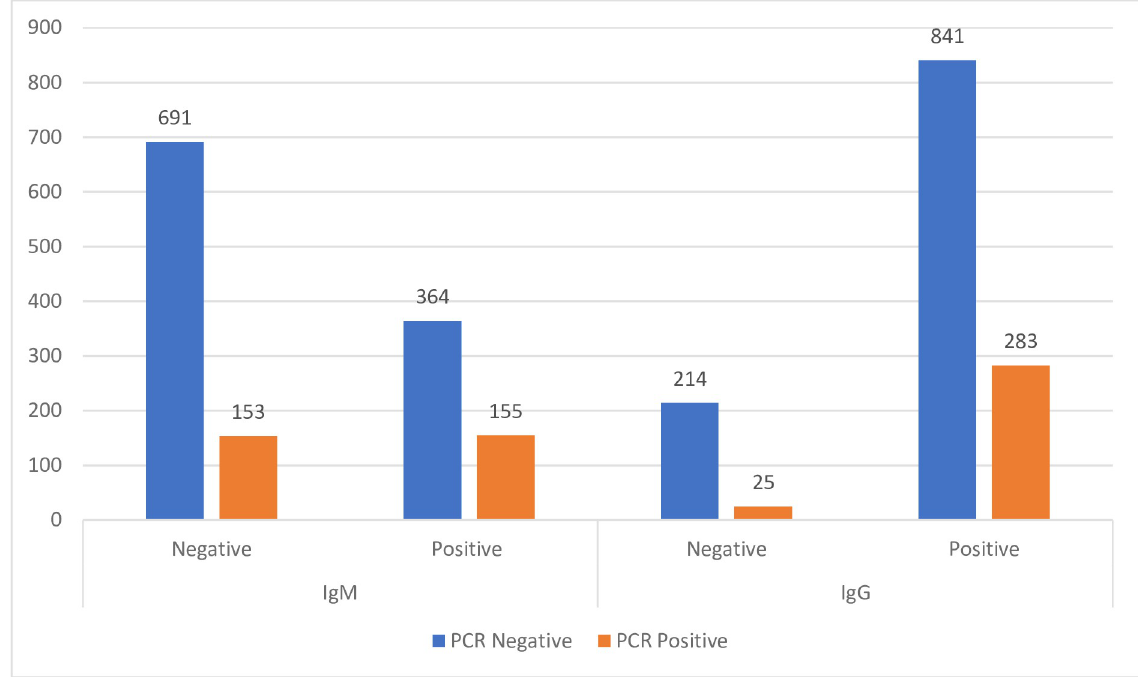
Fig 2. The distribution of SARS-CoV-2 serology groups in PCR positive and negative patients.